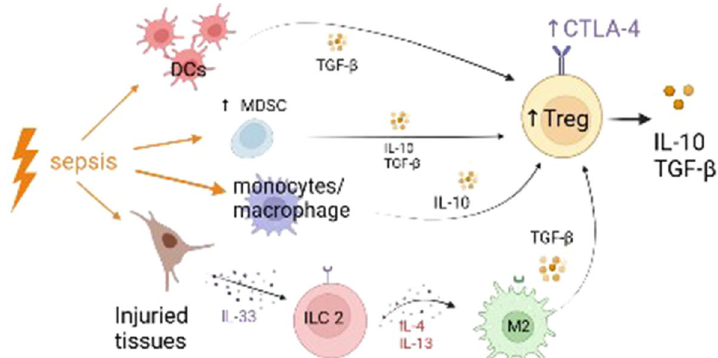
Fig. 2 Mechanisms of regulatory T cells (Tregs) increase during sepsis. The increase of Tregs in sepsis is mediated by the production of TGF-β IL-10 by dendritic cells, monocytes/macrophages and MDSCs. ± Moreover, the injured tissues produce IL-33 which in turn activates ILC2 cells. Activated ILC2 cells release IL-4 and IL-13, cytokines responsible for a polarization of macrophages toward a M2 phenotype, which release TGF-β. DCs: dendritic cells; Treg: regulatory T cells; MDSC: myeloid-derived suppressor cells; TGF-β: transforming growth factor β; CTLA-4: cytotoxic T-lymphocyte-associated protein 4; IL-10: interleukin 10; IL-4: interleukin 4; IL-33: interleukin 33; ILC 2: type 2 innate lymphoid cells, M2: type 2